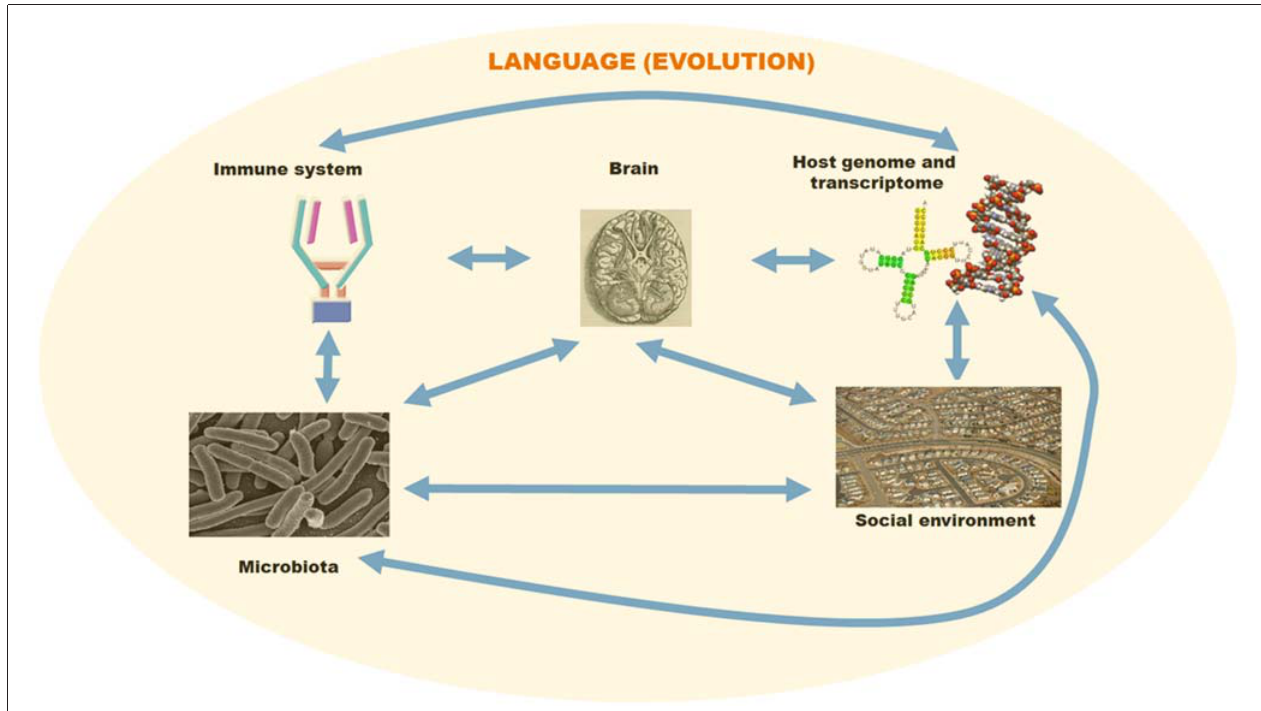
FIGURE 1 | A schematic overview of the different factors involved in language evolution. The language faculty was brought about by changes in the primate genome and transcriptome. However, environmental cues may have contributed as well to some of the changes facilitating the emergence of modern languages. Host-pathogen interactions may have affected brain and language evolution via direct effects on brain development and indirect effects on social behavior. For this figure, pictures have been taken from Wikipedia and subsequently adapted/arranged in a composite